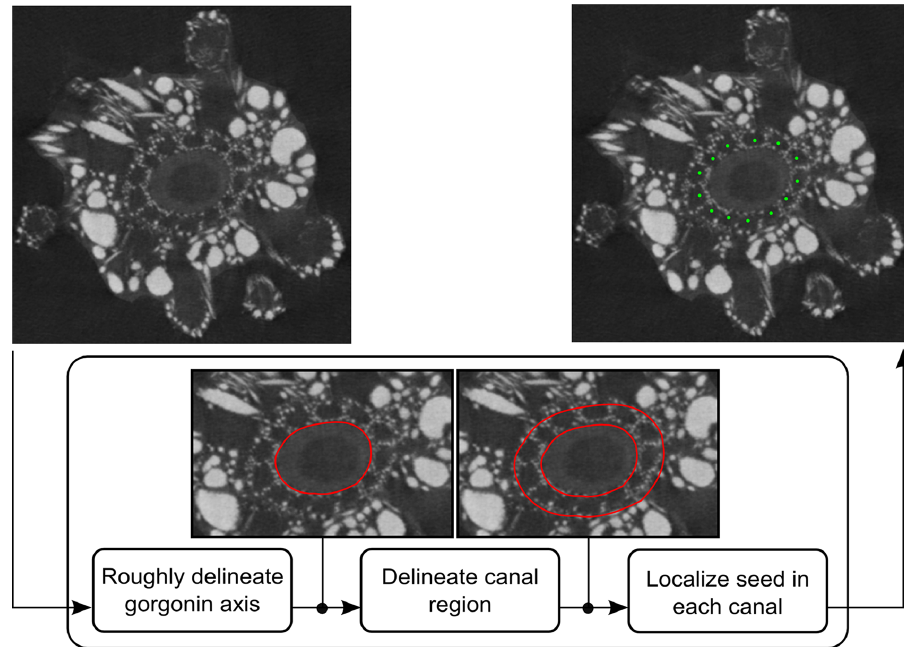
Figure 9. Flowchart of the automated seed-localization algorithm.